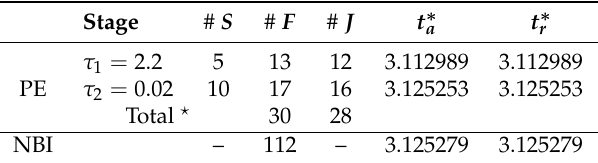
Table 2. Numerical results for MOP